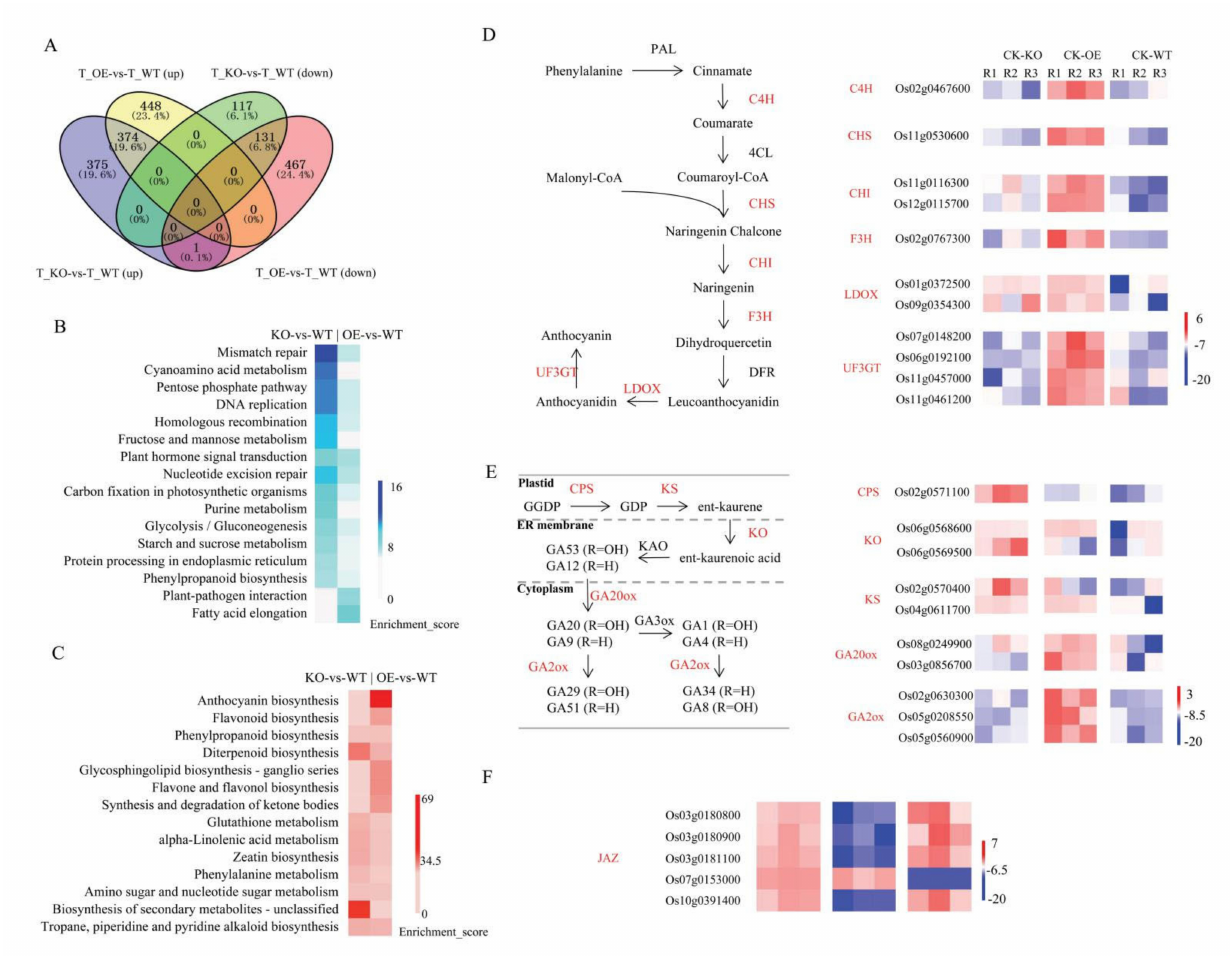
Figure 6. Differentially expressed genes (DEGs) among the transgenic lines and wild-type plants under osmotic stress. ( A ) Overlap of up and downregulated DEGs between OsGA2ox8 overexpression and CRISPR/Cas9 knockout lines com- pared with the wild type under osmotic stress. ( B ) KEGG pathway enrichment of the uniquely downregulated genes in the KO-2 and OE-2 lines, compared with wild-type plants. ( C ) KEGG pathway enrichment of the uniquely upregulated genes in the KO-2 and OE-2 lines compared with wild-type plants. ( D ) Diagram of the anthocyanin biosynthetic pathway in Arabidopsis and the expression levels of DEGs participating in the anthocyanin biosynthetic process. C4H: cinnamate 4-hydroxylase, PAL: phenylalanine ammonia lyase, CHI: chalcone isomerase, 4CL: 4-coumaroyl:CoA-ligase, DFR: dihy- droflavonol reductase, CHS: chalcone synthase, F3H: flavanone 3-hydroxylase, LDOX: leucoanthocyanidin dioxygenase, UF3GT: UDP-Glc:flavonoid 3-O-glucosyltransferase. ( E ) Diagram of the GA biosynthetic pathway and the expression levels of DEGs participating in the GA biosynthetic process. GGDP: trans-geranylgeranyl diphosphate, KO: ent-kaurene oxidase, KS: ent-kaurene synthase, CPS: ent-copalyl diphosphate synthase, GA20ox: gibberellin 20 oxidase, KAO: ent-kaurenoic acid oxidase, GA3ox: gibberellin 3 beta-hydroxylase, GA2ox: gibberellin 2 oxidase. ( F ) Expression levels of jasmonate ZIM domain-containing proteins under osmotic stress. The heatmap presents normalized log 2 FPKM expression